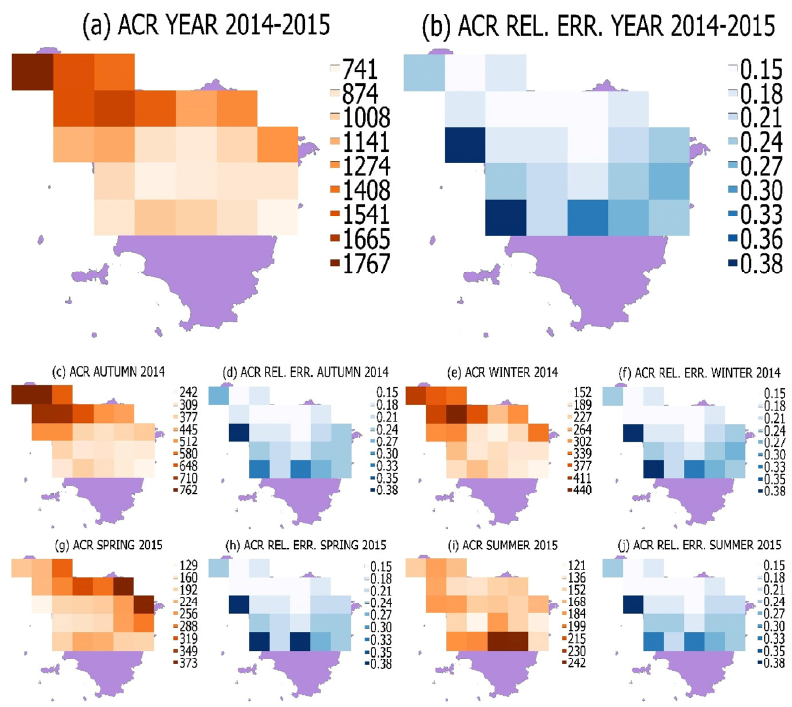
Figure 5. Annual ( a ) and seasonal ( c , e , g , i ) ACR (mm) and their relative errors ( b , d , f , h , j ), for all areas, year: 2014–2015.